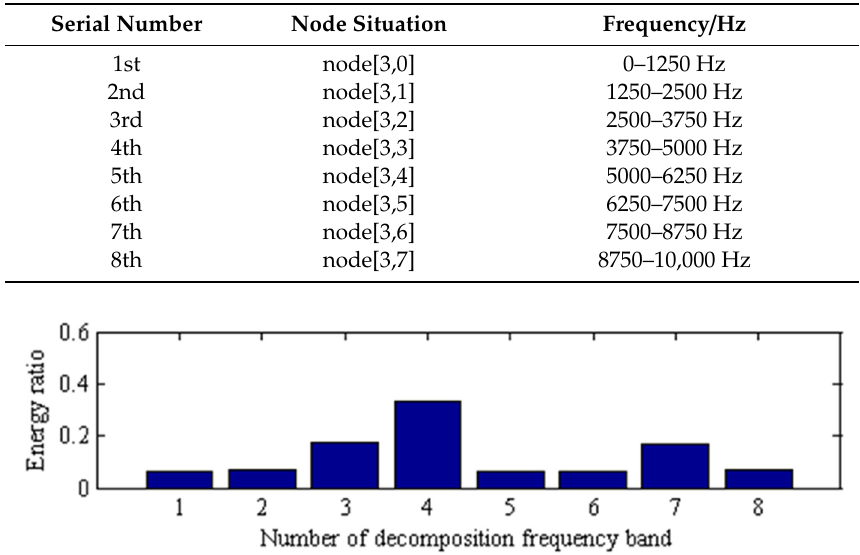
Appl. Sci. 2020 , 10 , x FOR PEER REVIEW Figure 6. Energy distribution proportional histogram of simulated signal. Figure 6. Energy distribution proportional histogram of simulated signal.